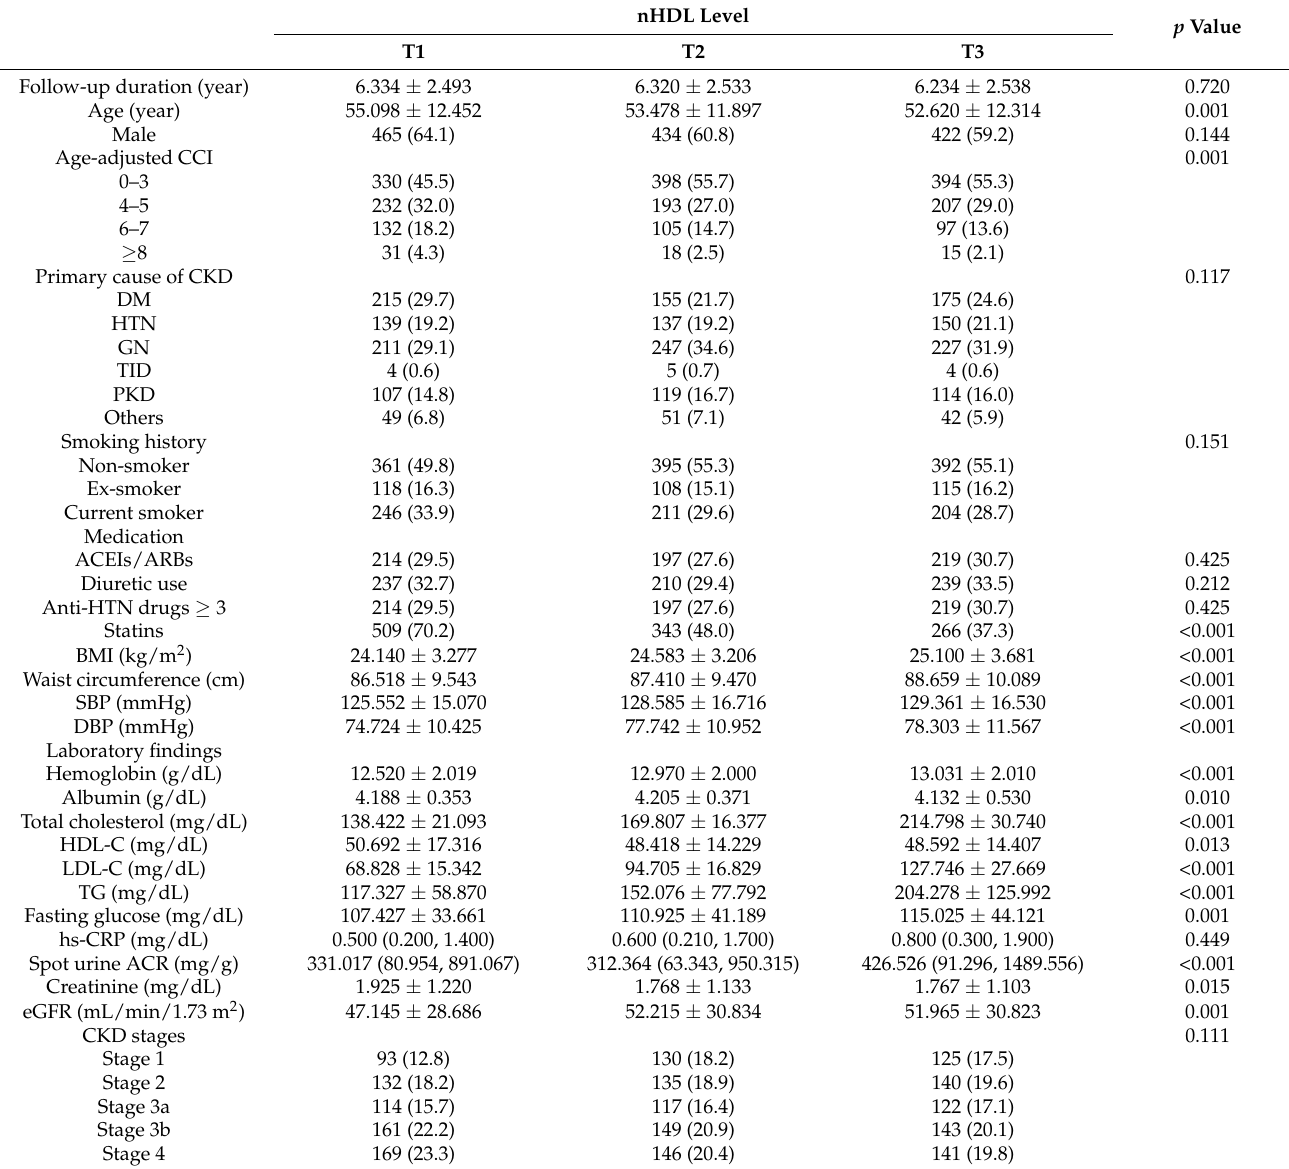
Table 1. Baseline characteristics of study participants by nHDL